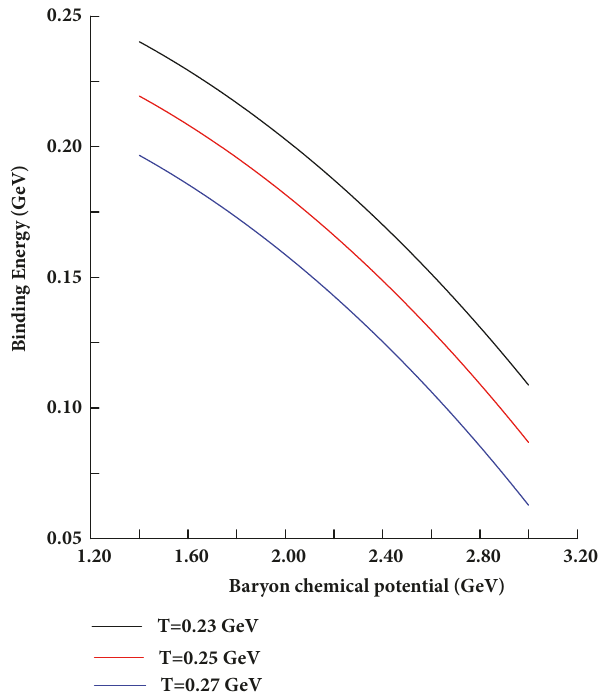
Figure 8: The binding energy 1S charmonium is plotted as a function of baryonic chemical potential for different values of temperature at 𝜉 = 0.